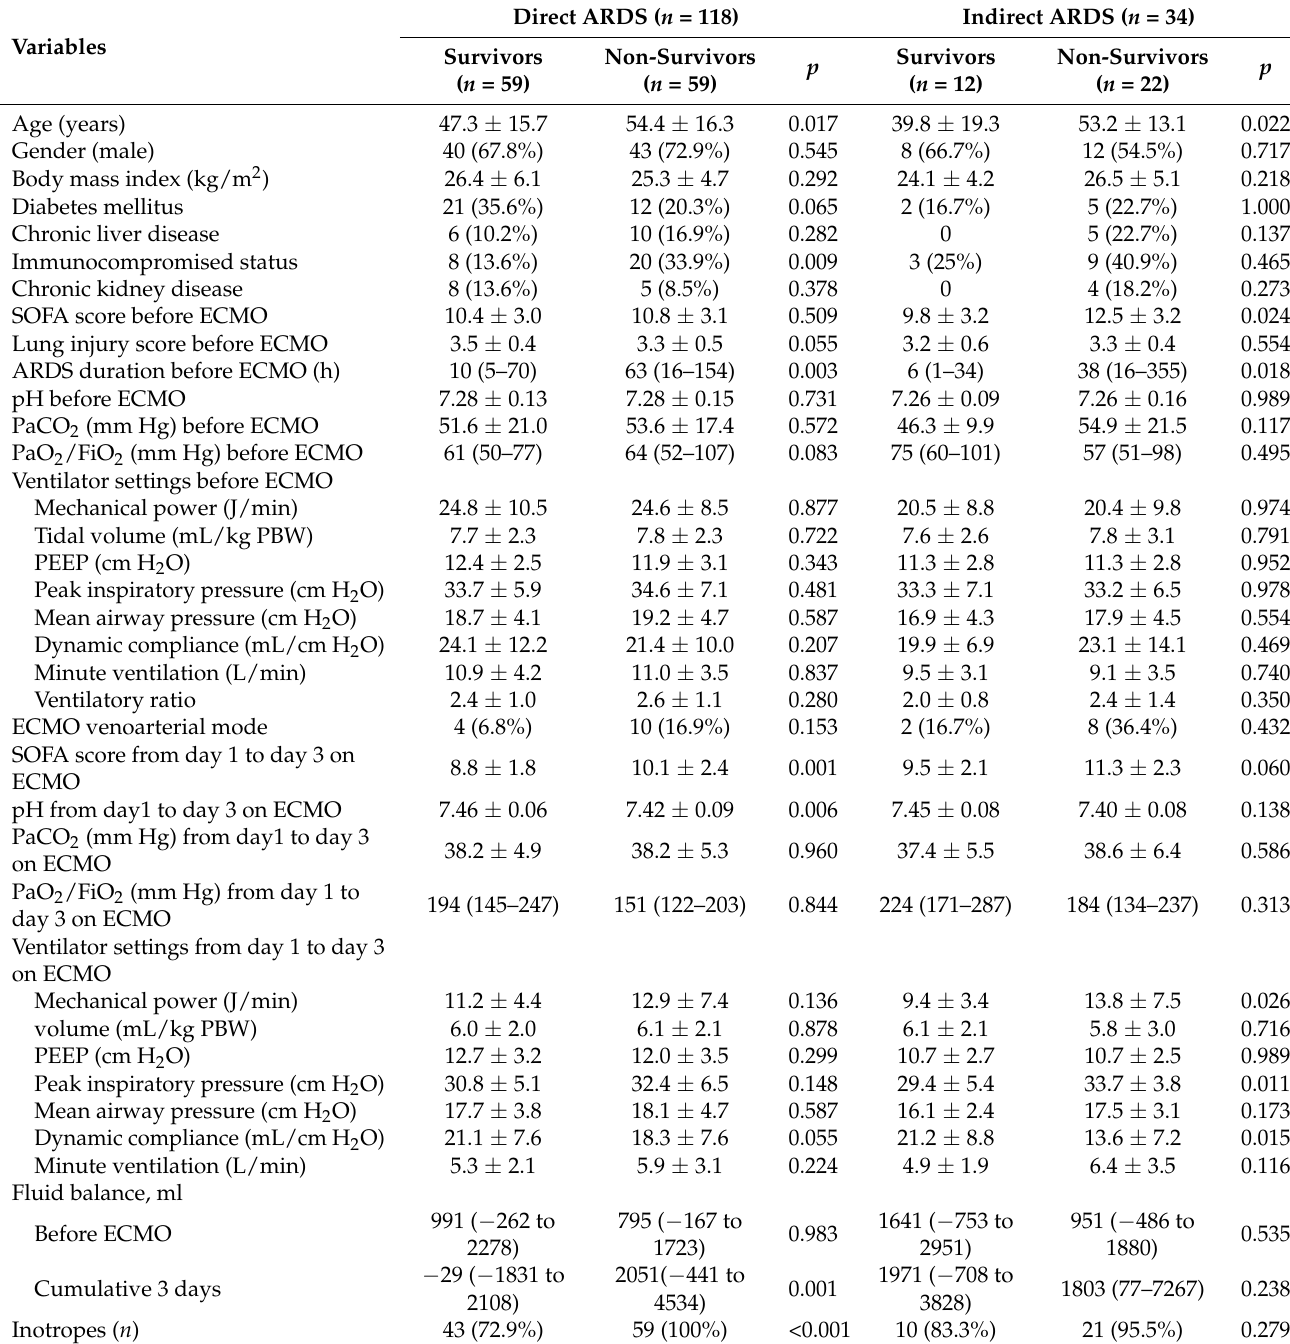
Table 3. Background characteristics and clinical variables of survivors and non-survivors: Direct and indirect ARDS